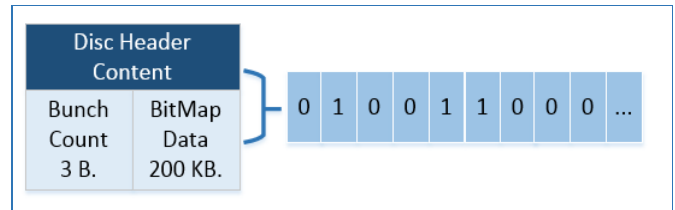
Figure 6. Structure of disc header .